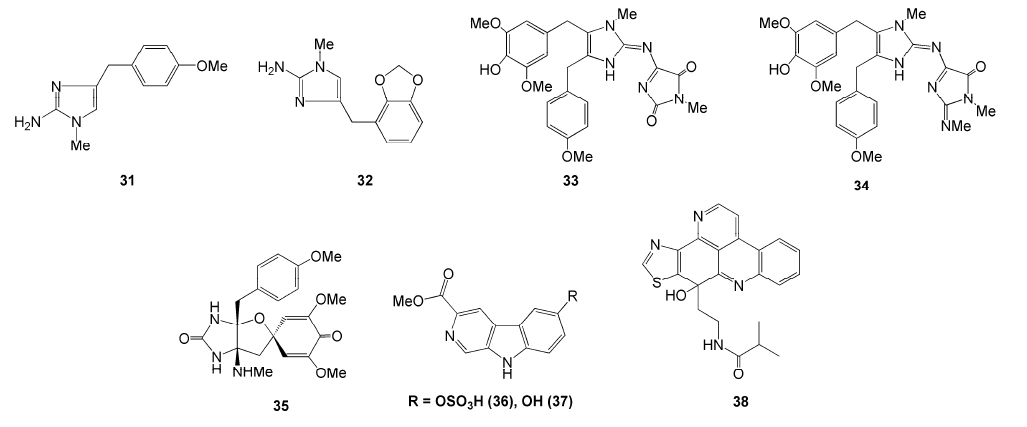
Figure 3. Chemical Structures of 31–38.